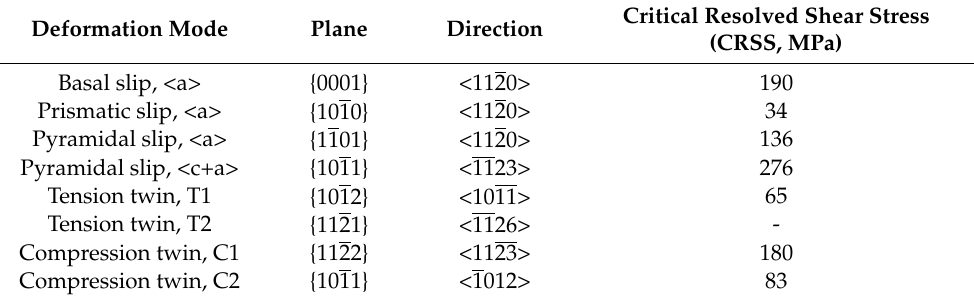
Table 4. Main slip and twin systems of commercially pure titanium [21].